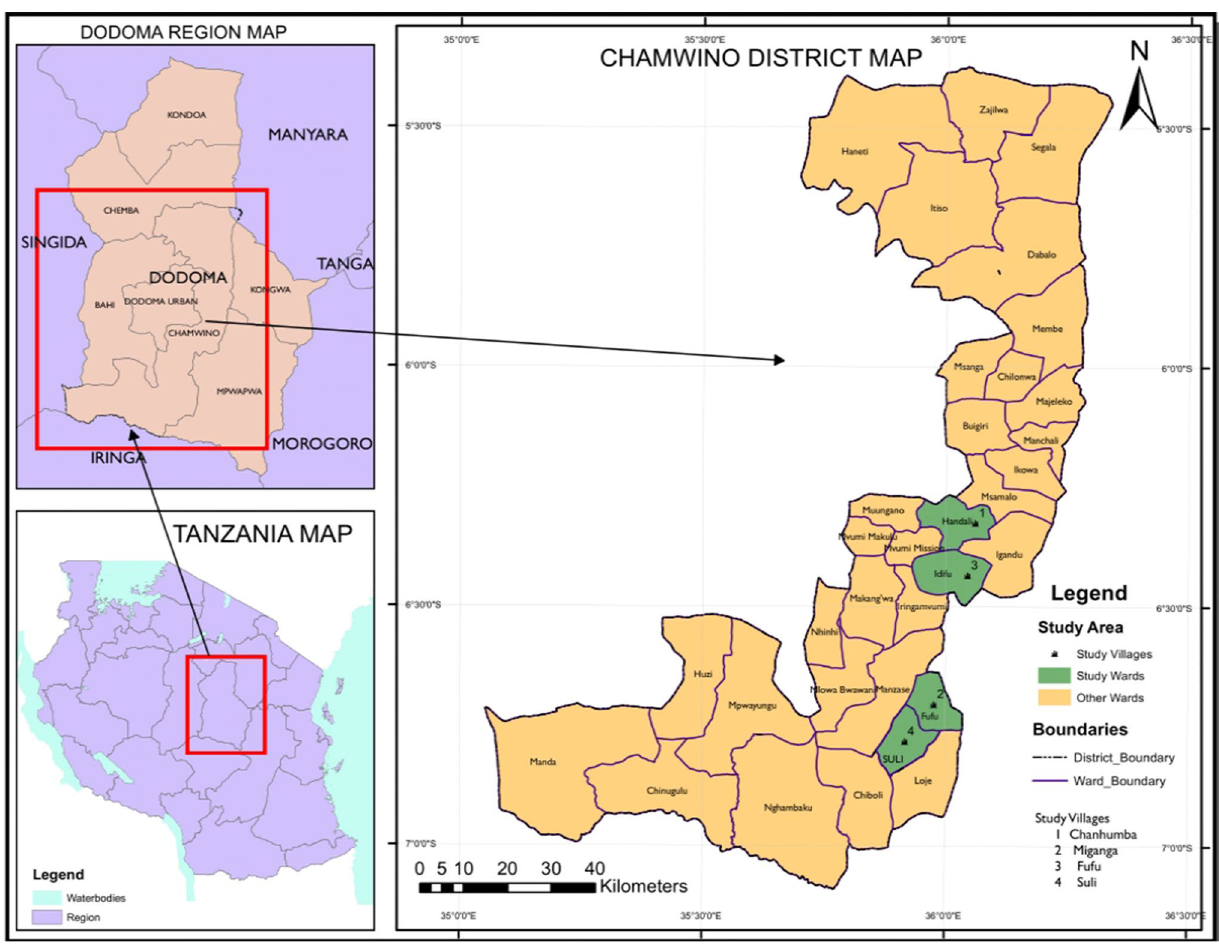
Fig. 1 Map of Chamwino District showing study